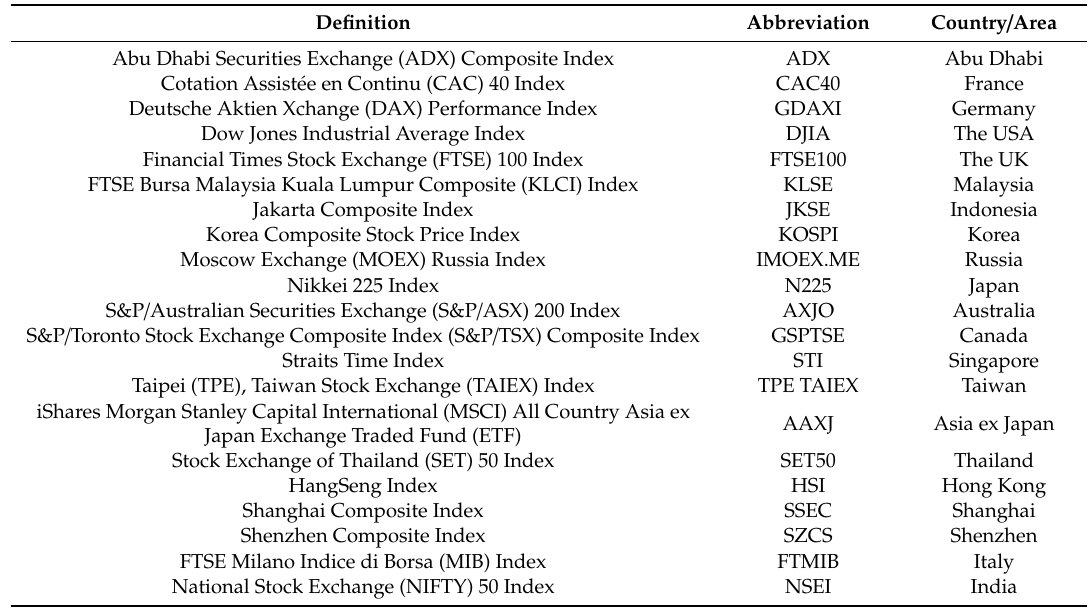
Table 2. Selected indices for a ff ected countries and